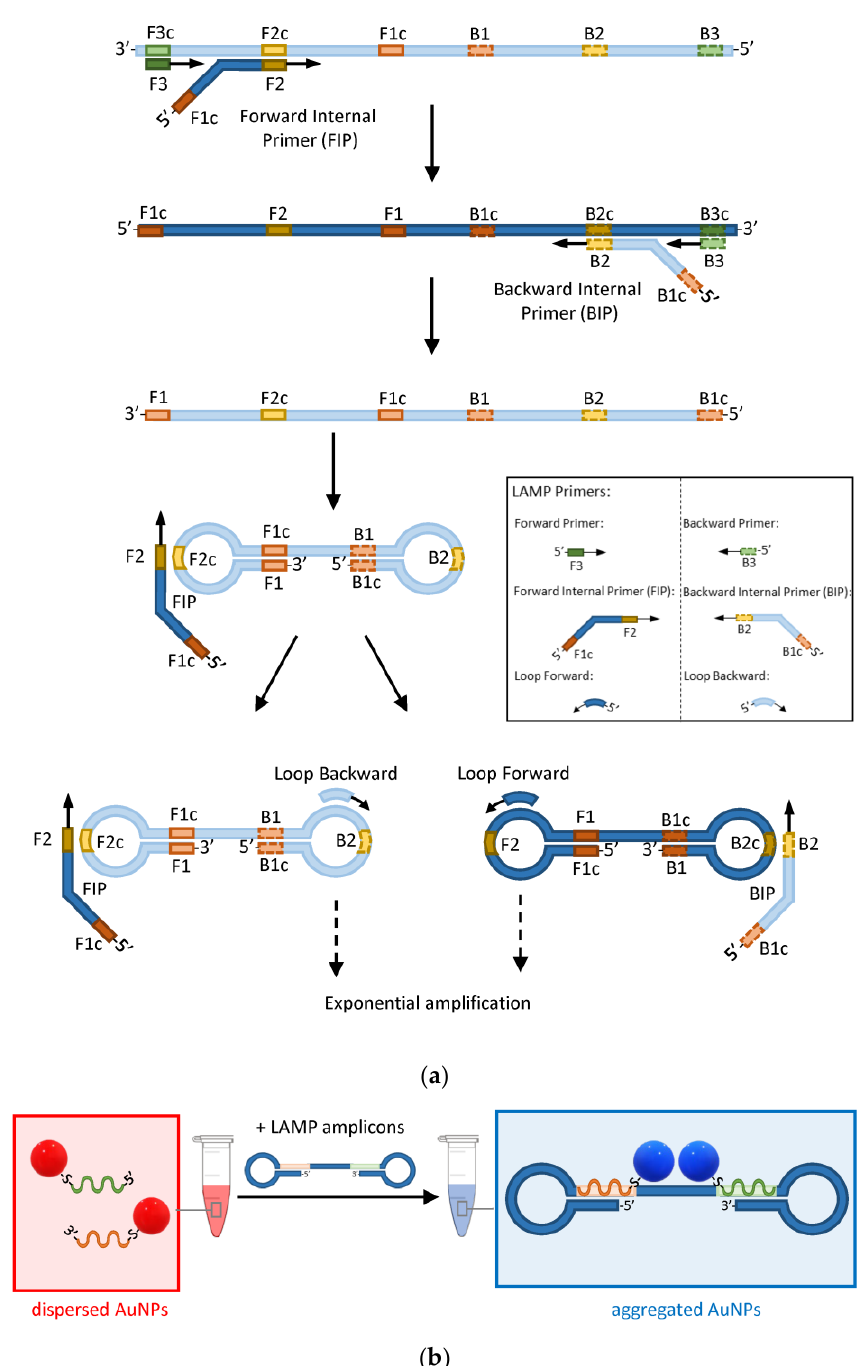
Figure 5. The principle of AuNP-enhanced LAMP assays. ( a ) Schematic of the main steps involved in the amplification of DNA by LAMP. Light and dark blue represent complementary strands. Green, orange, and yellow rectangles represent the forward (solid outline) and backward (dashed outline) primers’ target sequences and their complements identified by the letter ‘c’. ( b ) Detection of LAMP amplicons by hybridization of a pair of AuNP–ASOs to complementary regions on the target DNA (orange and green rectangles).